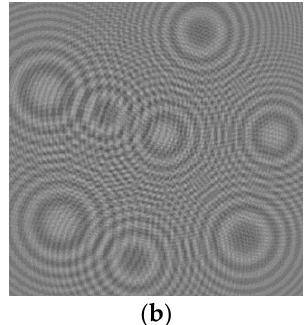
Figure 3. Two artificially generated 2-D mixed multiple fringe patterns composed of ( a ) six and ( b ) eight circular fringe patterns.